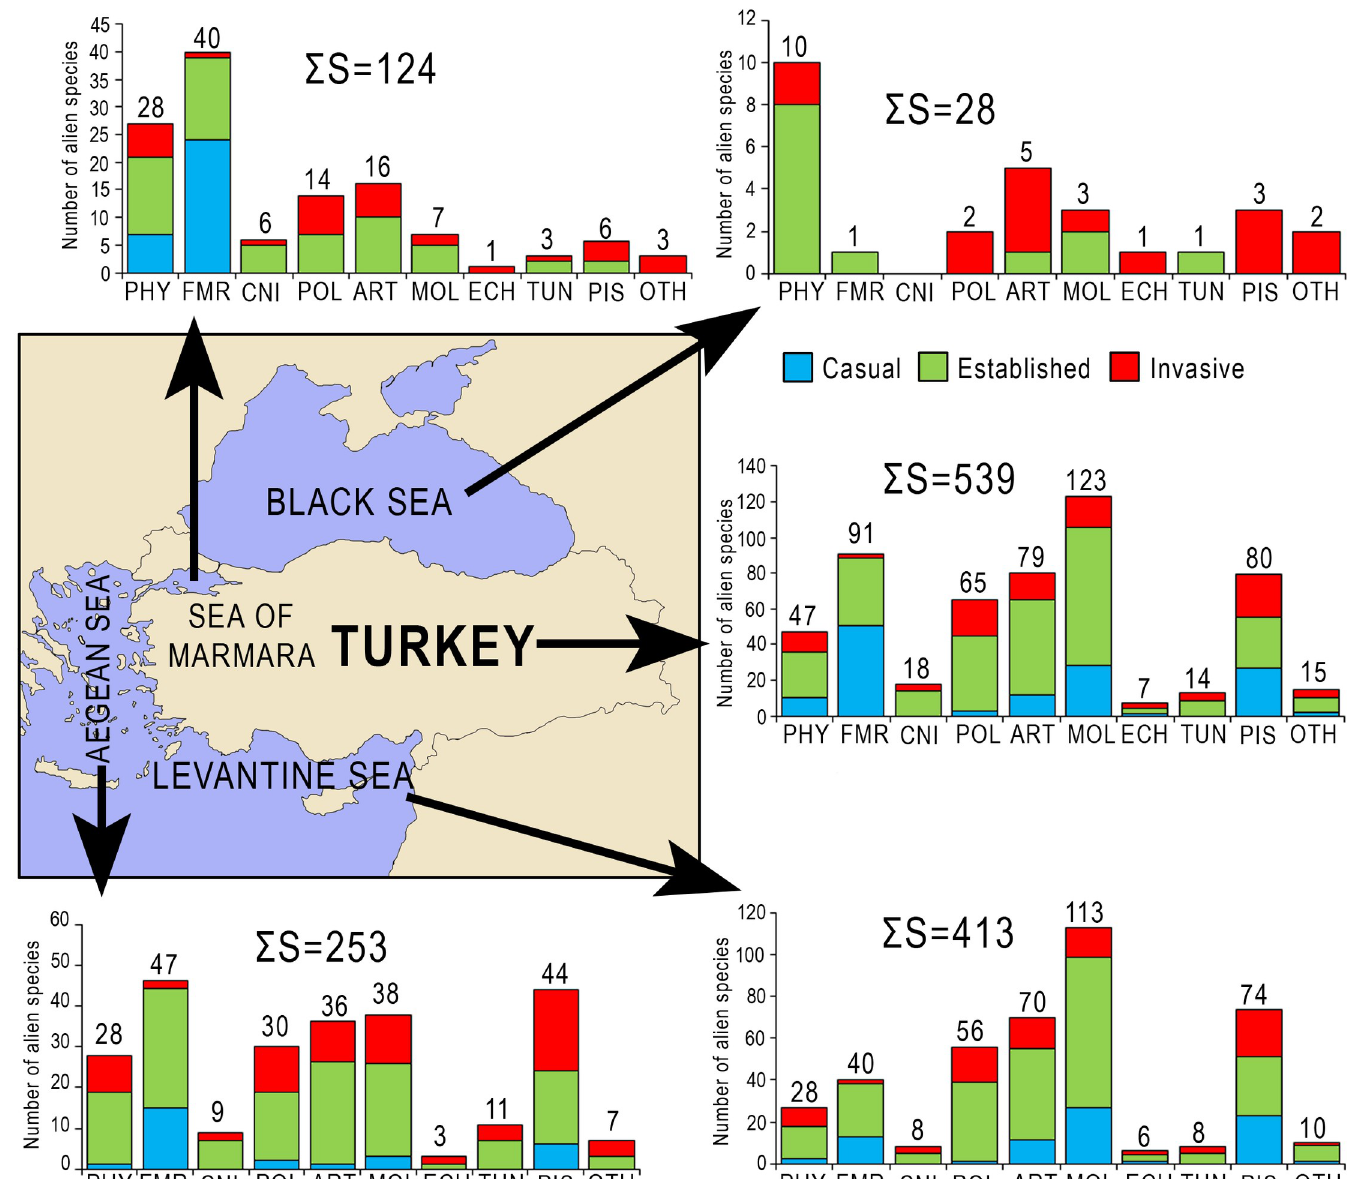
Fig 3. Number of alien species in four seas surrounding Turkey, and their distributions to major groups and their establishment success in each sea. PHY: Phytobenthos, FMR: Foraminifera, CNI: Cnidaria, POL: Polychaeta, ART: Arthropoda, MOL: Mollusca, ECH: Echinodermata, TUN: Tunicata, PIS: Pisces, OTH: